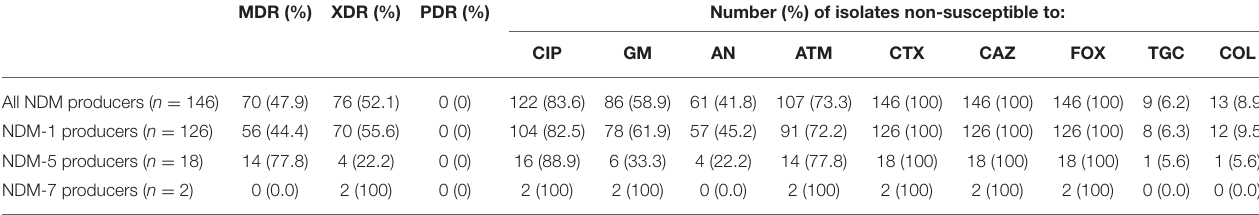
Number (%) of isolates non-susceptible